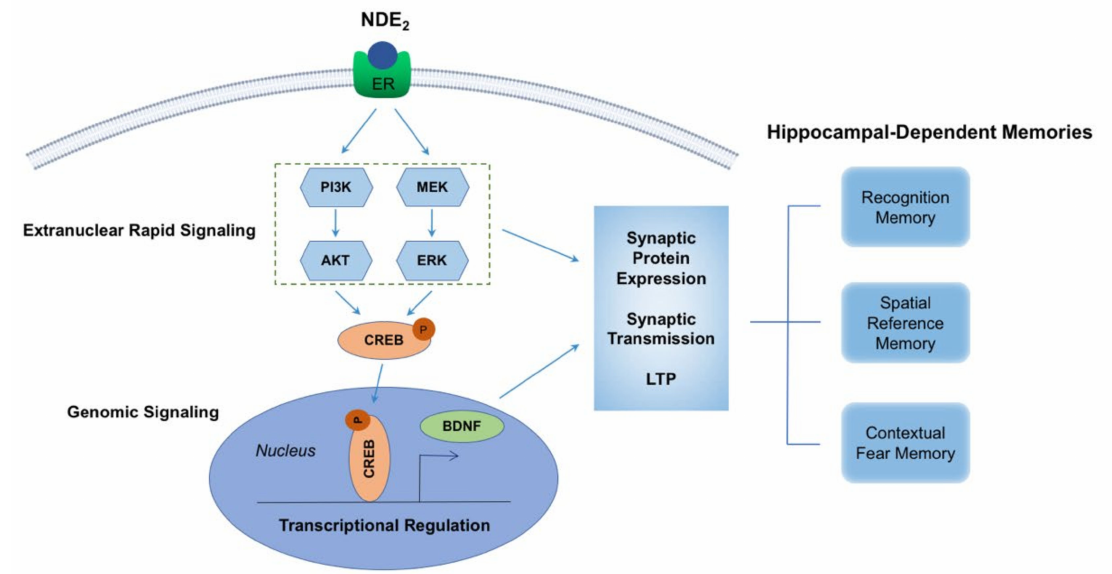
Figure 5. Schematic illustration for the proposed mechanisms underlying NDE 2 regulation of neuroplasticity and hippocampal-dependent memory. NDE 2 regulates hippocampal neuroplasticity predominantly through the activation of extranuclear rapid signaling, which includes PI3K-AKT and MEK-ERK pathways. Both PI3K-AKT and MEK/ERK signaling have been implicated in rapidly mediating synaptic plasticity by enhancing synaptic transmission and long-term potentiation (LTP). In addition, PI3K-AKT and MEK/ERK signaling also facilitates the synthesis and transport of synaptic proteins that are necessary for synaptic plasticity. NDE 2 can also promote CREB activation, which transactivates BDNF transcription via genomic signaling, which can crosstalk with the rapid signaling pathways to mediate synaptic functions and hippocampus-dependent memory, such as recognition memory, spatial reference memory, and contextual fear